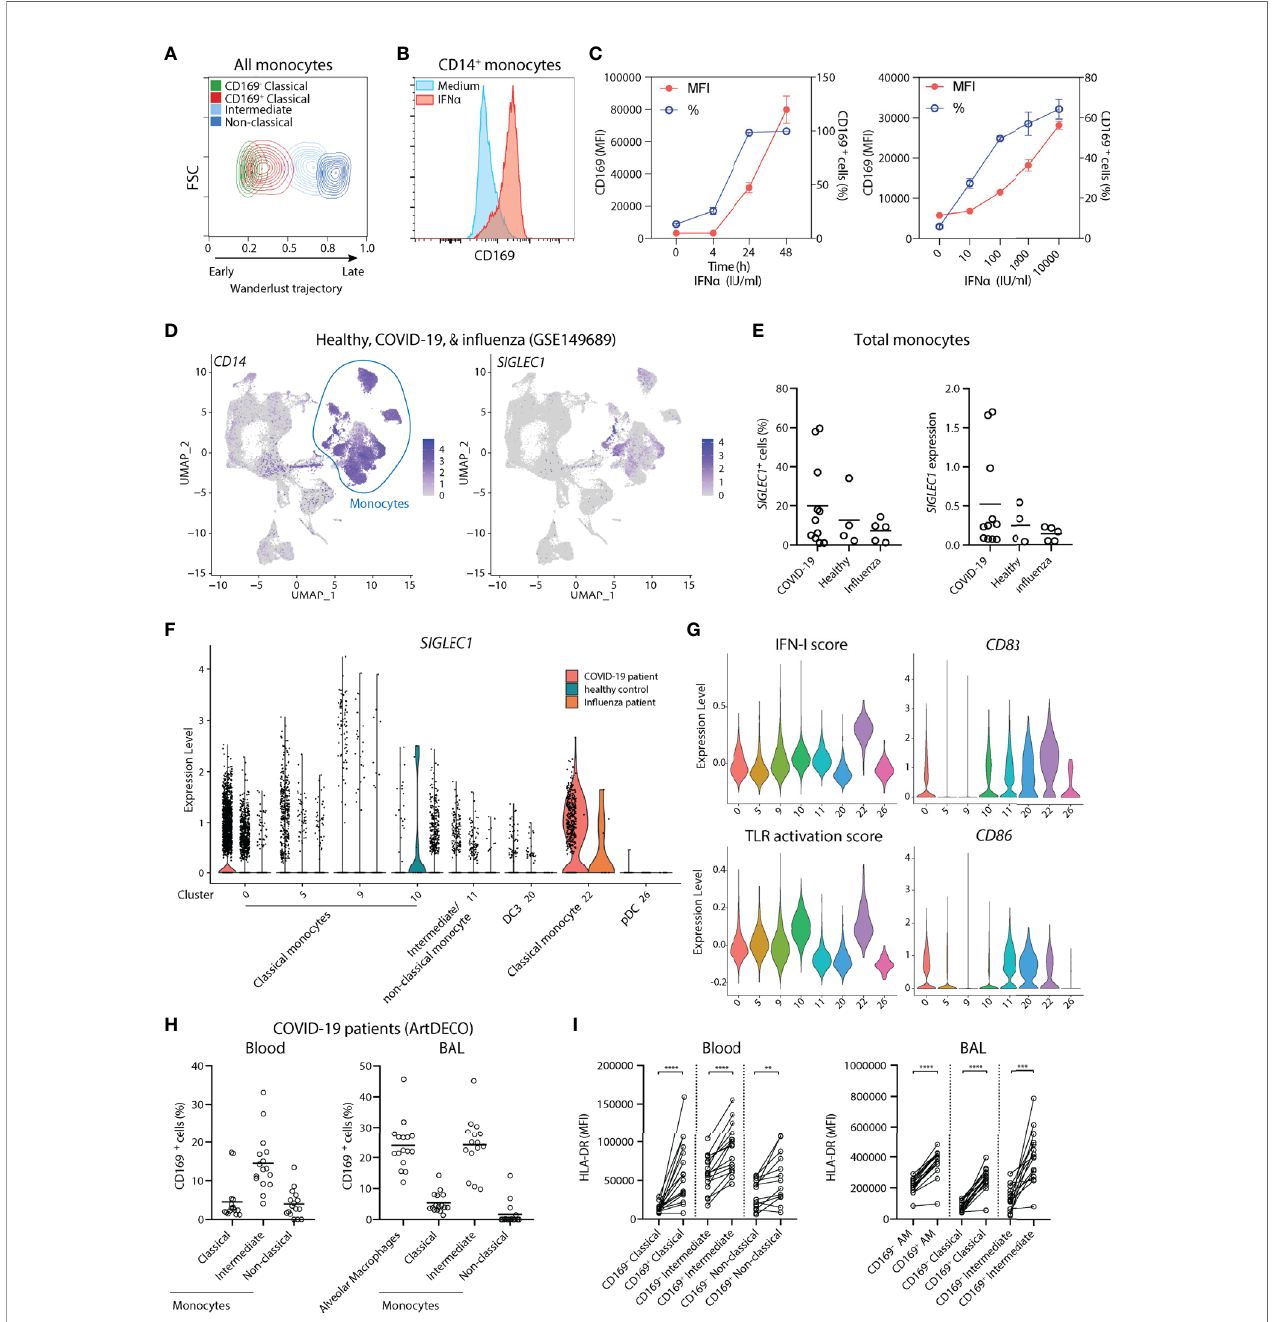
FIGURE 2 | CD169 expression in monocytes is driven by IFN-I and CD14 + CD169 + monocytes are present in COVID-19 patients. (A) Wanderlust trajectory analysis of monocyte population using CD14 + CD169 - monocytes as starting population overlaid by conventional gating of monocyte subsets. (B, C) CD14 + monocytes were isolated and treated with 1,000 IU/ml IFN a for 24h unless indicated otherwise. Percentage of CD169 + cells or CD169 median fl uorescence intensity (MFI) of CD169 + population are shown. ( n = 4). (D – G) Analysis of public scRNA-seq dataset of PBMCs from patients with COVID-19 ( n = 9), severe in fl uenza ( n = 5) and healthy controls ( n = 4) using Seurat pipeline. (D) UMAP analysis showing the expression of CD14 and SIGLEC1 . (E) SIGLEC1 expressing monocytes as shown as percentages or MFI in different groups. (F) Violin plot of SIGLEC1 expression in clusters of monocytes and DC subsets from each patient group. (G) Violin plots of IFN-I score, TLR activation score, maturation markers CD83 and CD86 , in monocytes and DC clusters of all groups. (H, I) Spectral fl ow cytometry analysis of COVID-19 patients (ArtDECO cohort) of CD169-expressing monocytes/macrophages in circulation or bronchoalveolar space. (H) Percentage of CD169 + cells within monocytes subsets or alveolar macrophages (AM) ( n = 16) in the (left panel) blood or (right panel) BALF of COVID-19 patients. (I) Expression of HLA-DR compared between CD169 + and CD169 - subsets of monocytes or alveolar macrophages (AM). Paired t-tests were used. **P < 0.01, ***P < 0.001, ****P <